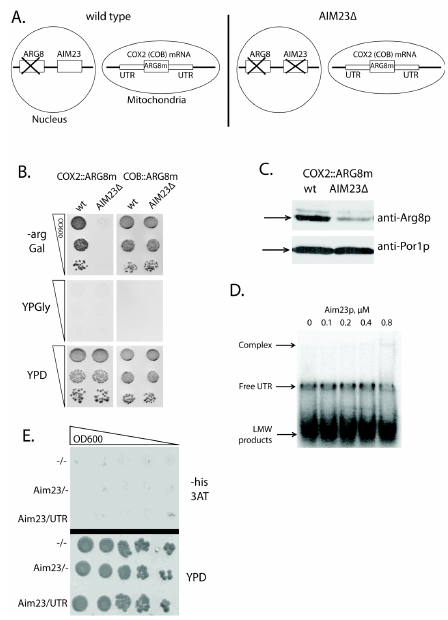
Figure 1. The detection of genetic, but not physical, interaction of Aim23p with untranslated regions (UTRs) of COX2 mRNA. ( A ) Scheme of nuclear and mitochondrial DNA organization of the yeast strains used in the experiments. Wildtype: eitherHMD22strain( COX2::ARG8m [22])orMRSI 0 ∆ COBstrain( COB::ARG8m [23]). AIM23 ∆ : the same strains with AIM23 genomic disruption. ( B ) The plates with different media (indicated on the left: -arg Gal— synthetic arginine-lacking medium with galactose, YPGly—glycerol-containing full medium, YPD—glucose-containing rich medium) after two days of growth of the yeast strains indicated on the top. The ten-fold consecutive dilutions of the yeast suspensions were plated. The experiment was done in three biological replicates; the characteristic picture is presented. ( C ) Western-blot hybridization of mitochondrial proteins isolated from the above-mentioned strains with anti-Arg8p antibodies (top part; kindly provided by Martin Ott). As a loading control, the same samples were blotted with anti-porin 1 antibodies (bottom part; produced by Almabion, Russia). The corresponding protein bands are marked with arrows. The experiment was done in three biological replicates; the characteristic picture is presented. ( D ) Results of the gel-shift experiment. In vitro synthesized COX2 mRNA 5 (cid:48) -UTR was labeled with 32 P-ATP and then incubated with different amounts of the recombinant Aim23p (molar concentrations of the protein are indicated on the top). Reaction products were separated using native Polyacrylamide Gel Electrophoresis (PAGE) and visualized by radioautography. The gel zones corresponding to low molecular weight (LMW) products, free UTR and UTR complex with Aim23p are marked by the arrows on the left. The experiment was done in three biological replicates; the characteristic picture is presented. ( E ) Results of the three-hybrid system assay. Three derivatives of the L40 coat yeast strain were analyzed: the first one was transformed by two empty vectors, pACT2 and pIIIA / MS2-1 ( − / − ); the second one was transformed by pACT2 vector with cloned AIM23 gene and by empty pIIIA / MS2-1 vector (AIM23 / − ); the third one was transformed by pACT2 vector with cloned AIM23 gene and by pIIIA / MS2-1 vector with the cloned sequence of the COX2 mRNA 5 (cid:48) -UTR (AIM23 / UTR). The names of the strains are depicted on the left. Top panel: growth on medium lacking histidine supplemented with the 3-amino-1,2,4-triazole (3-AT). Bottom panel: growth on the rich glucose-containing medium (YPD). The ten-fold consecutive dilutions of the yeast suspensions were plated. The experiment was done in four biological replicates; the characteristic picture is